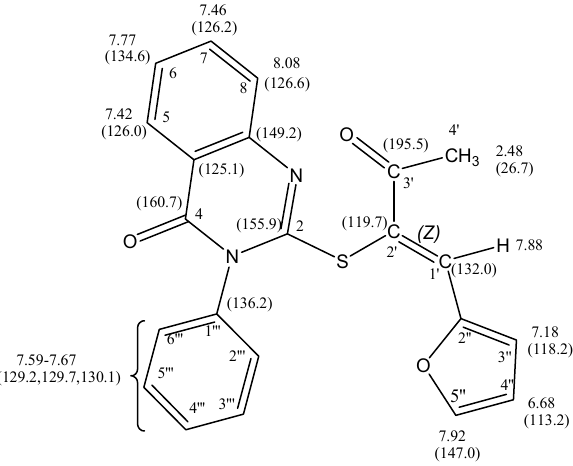
Figure 8. The complete assignment of H 1 and 13 C chemical shifts for 10 based on the COSY and HSQC